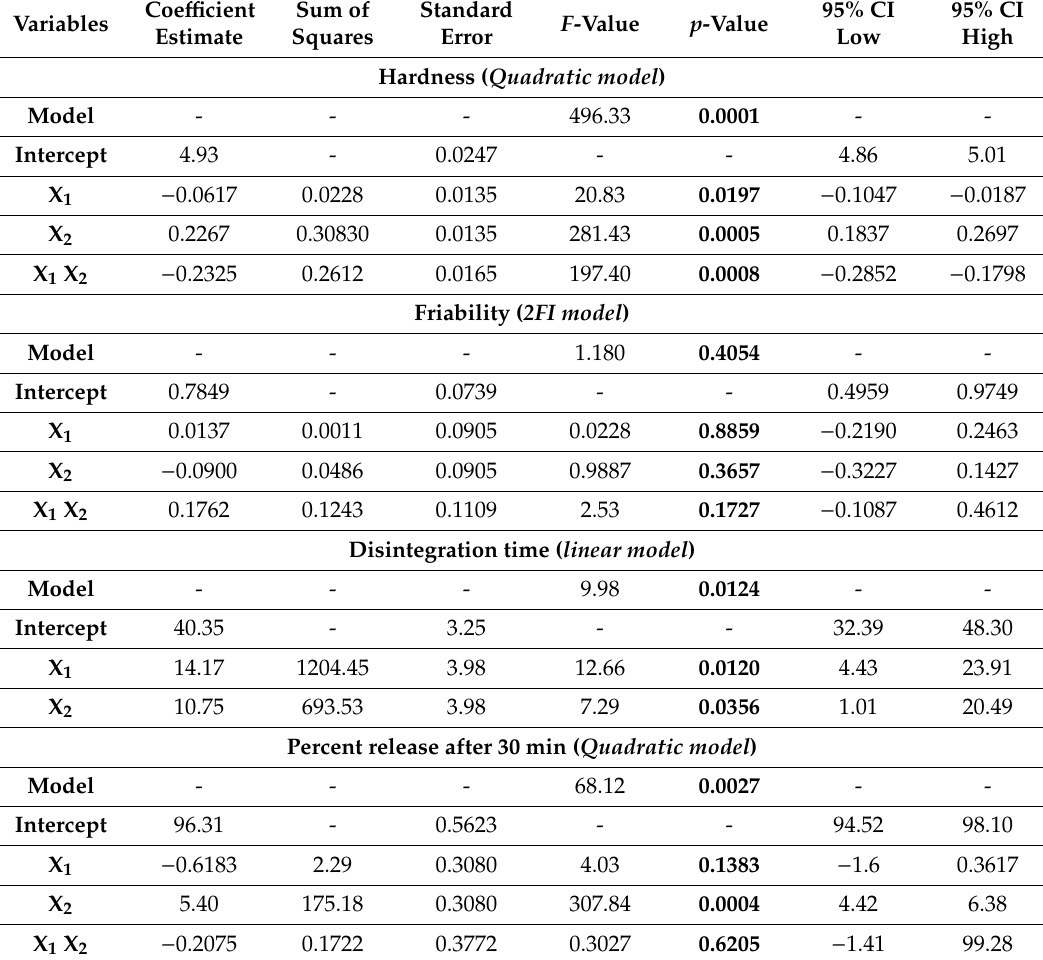
Table 2. Analysis of variance (ANOVA) summary and regression analysis of SUL-FDTs dependent